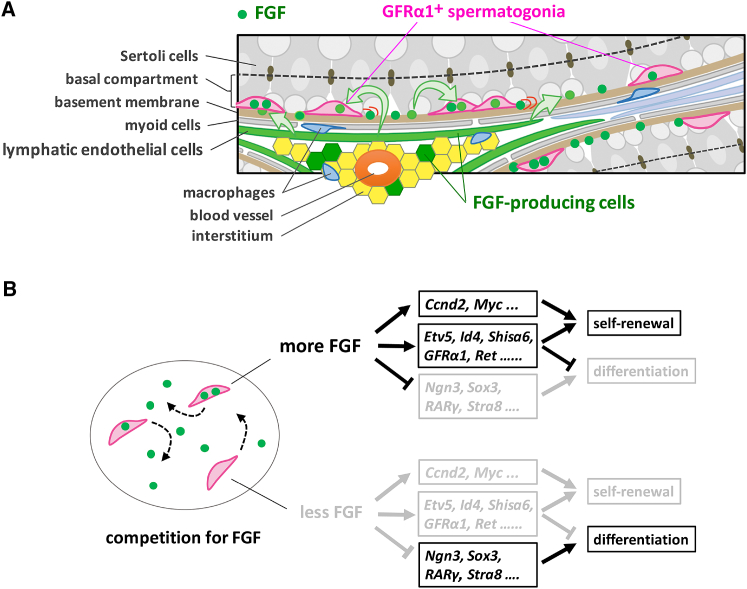
Proposed Stem Cell Regulation in Seminiferous Tubules by Mitogen Competition(A) A schematic of the microenvironment regulating GFRα1+ spermatogonia. In the basal compartment of seminiferous tubules, FGFs are produced and secreted by a subset of LE cells and a few interstitial cells. FGFs, which have an affinity to the basement membrane, are taken up and consumed by motile GFRα1+ spermatogonia and biases their fate behavior in a concentration-dependent manner (see B). This leads to higher local densities of GFRα1+ cells near the FGF source (near the interstitium accompanying arterioles or venules) compared to those distant from the source.(B) In the basal compartment, GFRα1+ cells effectively compete for a limited supply of FGF. Cells receiving larger amounts of FGF will show higher expression of cell-cycle-promoting and anti-differentiation genes and lower expression of differentiation-promoting genes, tilting their fate toward proliferation without differentiation. Cells receiving smaller amounts of FGF will show opposite patterns of target genes, tilting their fate toward differentiation.